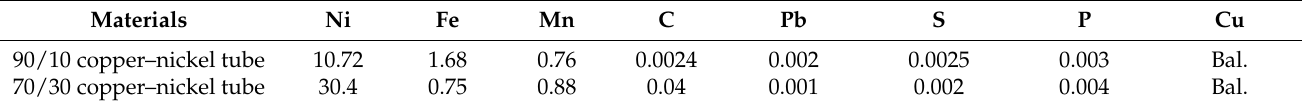
Table 1. Compositions (wt%) of the experimental copper–nickel